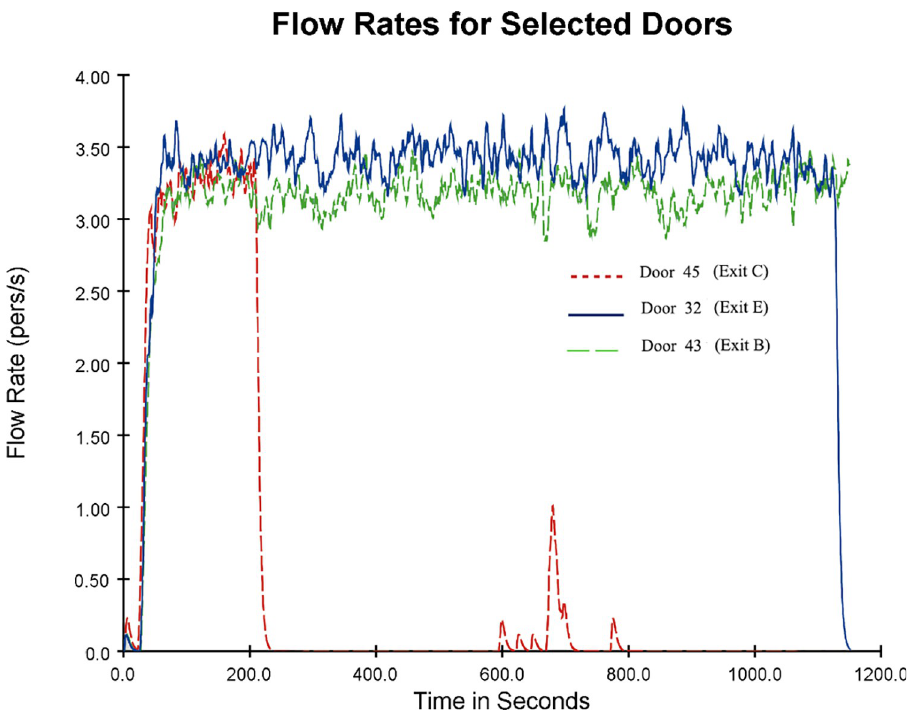
Fig 7. Flow variation diagram for Exits B, C and E (basic evacuation simulation